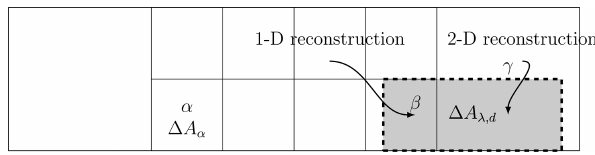
Figure 4. Illustration of the use of different reconstruction function in our modified scheme. The shaded area (cid:49)A λ, d is the departure cell of the arrival cell α . When the departure cell overlaps with the underlying Eulerian cell β , the size (refinement level) of the depar- ture cell and Eulerian cell are the same and a 1-D reconstruction function suffices. When the departure cell overlaps with the under- lying Eulerian cell γ , the size (refinement level) of the departure cell is smaller (higher) than the Eulerian cell and a 2-D reconstruction function is